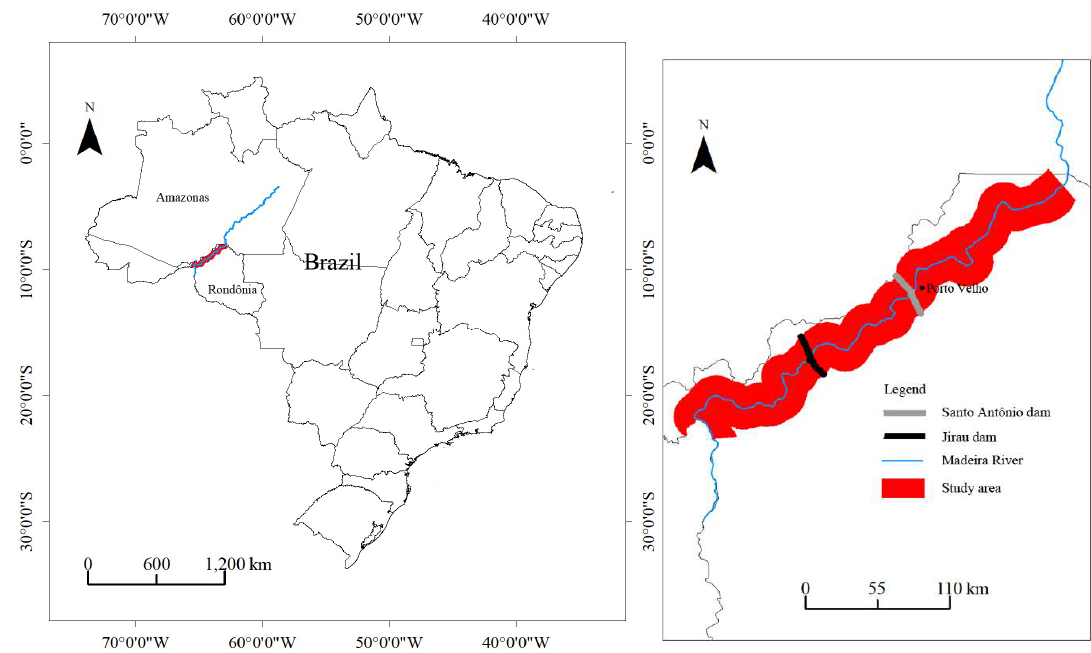
Figure 1. Location of the study area and two dams in the Madeira River in Brazil. Table 1. Key characteristics of the Jirau dam and Santo Antônio dam.